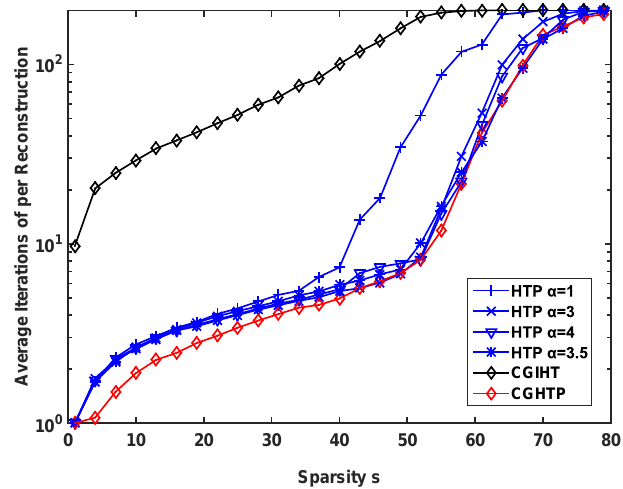
Figure 4. Number of iterations for HTP with different step size, CGIHT, and CGHTP algorithms.